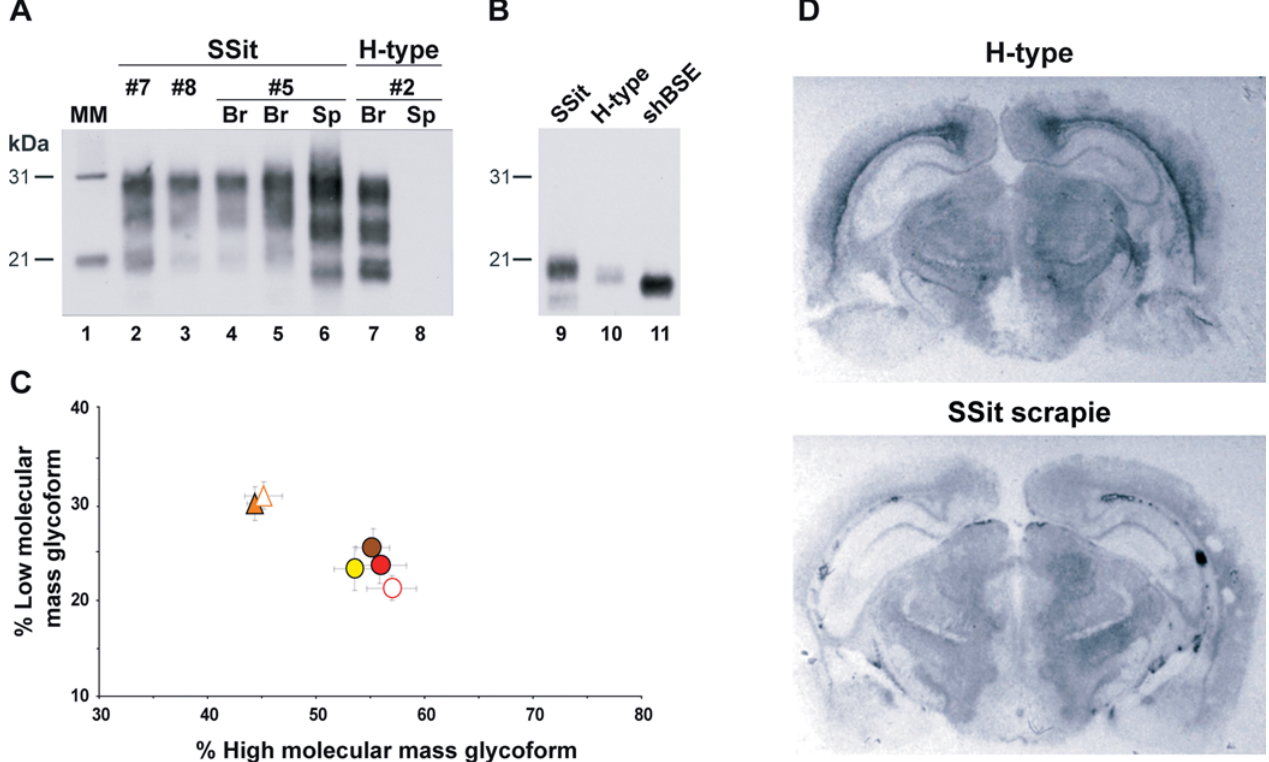
Figure 5. Comparison of H-Type and SSit Isolate Features upon Transmission to tgOv Mice (A and B) Western blot analysis of PrP res in the brains and spleens of tgOv mice infected with H-type or SSit isolates at first (lanes 2–4) and second passage (lanes 5–11). H-type PrP res shows a distinct pattern in the brain (Br) compared to SSit. The apparent molecular mass of SSit PrP res is higher than that of H-type or sheep BSE (shBSE), as shown after PNGase treatment (B). Note also that PrP res is detected in the spleen (Sp) of SSit- but not of H-type– infected mice. Tissue equivalent loaded: 1.5 mg in lanes 2–4; 0.04 mg in lane 5; 0.5 mg in lanes 6–7; 2 mg in lane 8; 0.01 mg in lane 9; 0.1 mg in lanes 10– 11. MM, molecular markers. (C) Ratio of high- and low-molecular-mass PrP res glycoforms in the brain of tgOv mice infected with H-type or SSit isolates (data plotted as mean 6 SEM). One H-type isolate (no. 2) is represented as orange triangle. SSit isolates are represented as circles (SSit no. 5, red; no. 7, brown; no. 8, yellow). Secondary transmissions are represented by unfilled symbols of the same colour. Note the stably distinct glycoform ratios between H-type and SSit agents upon serial passage. (D) Regional distribution of PrP res in the brain of tgOv mice infected with H-type or SSit isolates. Histoblots of representative coronal sections of tgOv mouse brains at the levels of the hippocampus are shown. The distribution of H-type–associated PrP res deposits was different from that of SSit in regions such as the alveus of the hippocampus, the corpus callosum, the pretectal nuclei, the cortex, and the ventromedial thalamus. Note that the size of PrP res deposits markedly differed between the two types of isolates. DOI: